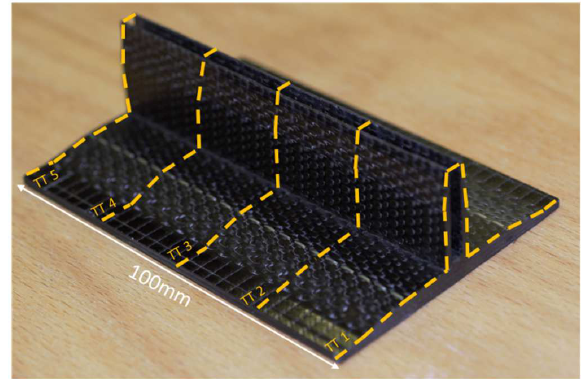
Figure 3. Sample map showing TT sections machined requiring eight cuts for each sample.